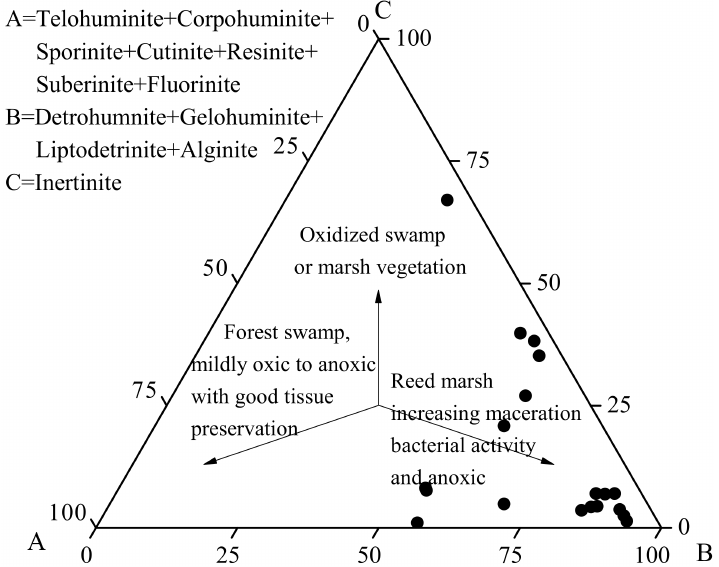
Figure 6. ABC ternary plot of the studied Shengli coal samples (after [56]). Reproduced with permission from Mukhopadhyay; published by